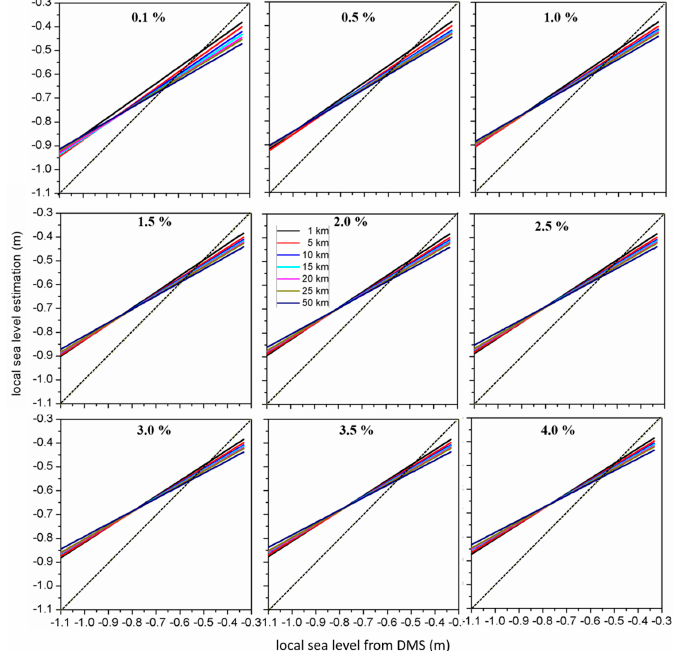
Figure 7. Linear fit lines of track 5 between retrievals from the lowest elevation method and those from the DMS method (ground truth) at 7 segment length scales: 1, 5, 10, 15, 20, 25, and 50 km, and 9 percentage scales: 0.1%, 0.5%, 1%, 1.5%, 2%, 2.5%, 3%, 3.5%, and 4%. The dashed line is the 1:1 line. All linear least square fits are statistically significant with greater than 95% confidence using an F test.